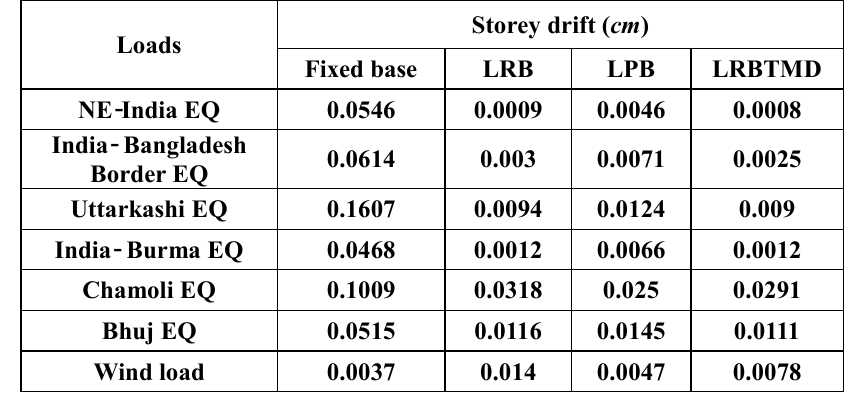
Maximum inter-storey